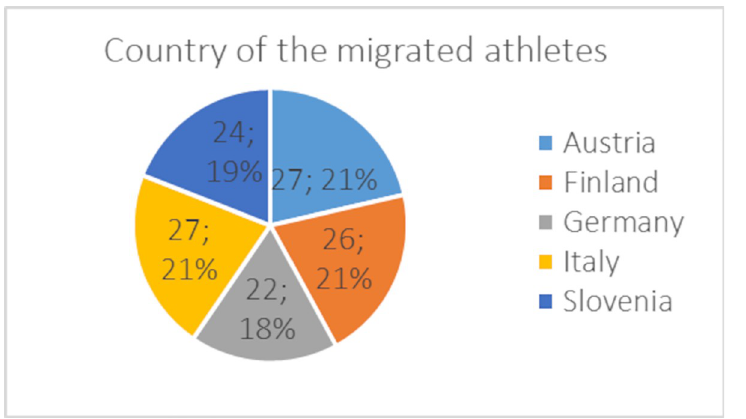
Fig 3. Country-related distribution ( n ; %) of migrating student-athletes.